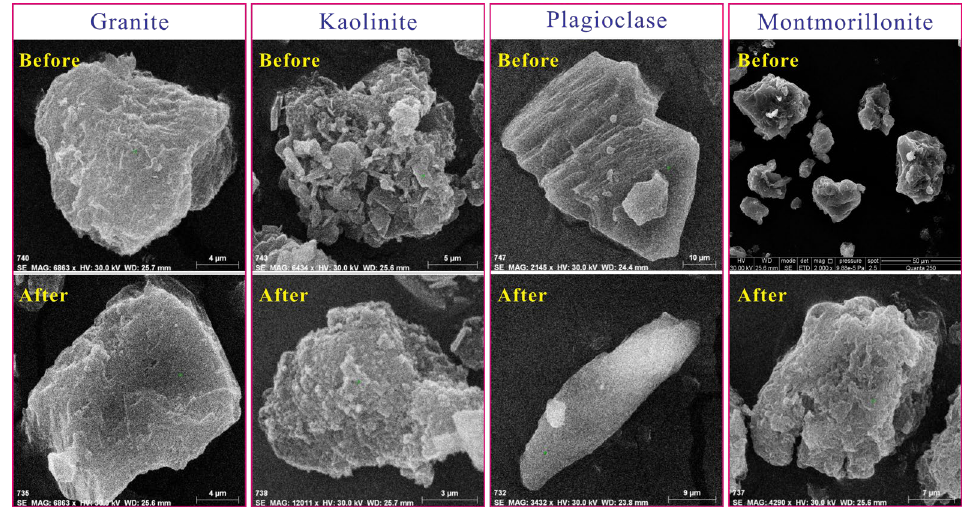
Figure 7. Morphological changes of mineral samples before and after soaking in oxalic acid solutions of 0.05 mol/L.